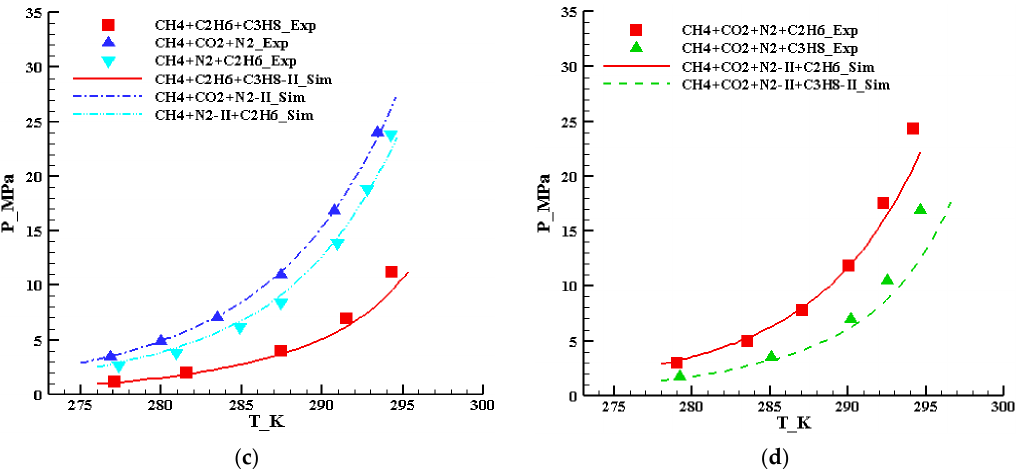
Figure 1. Simulated and measured formation pressures of hydrates in cases with various gas combinations. ( a ) Pure gas cases; ( b ) binary gases cases; ( c ) ternary gases cases; ( d ) quaternary gases cases.